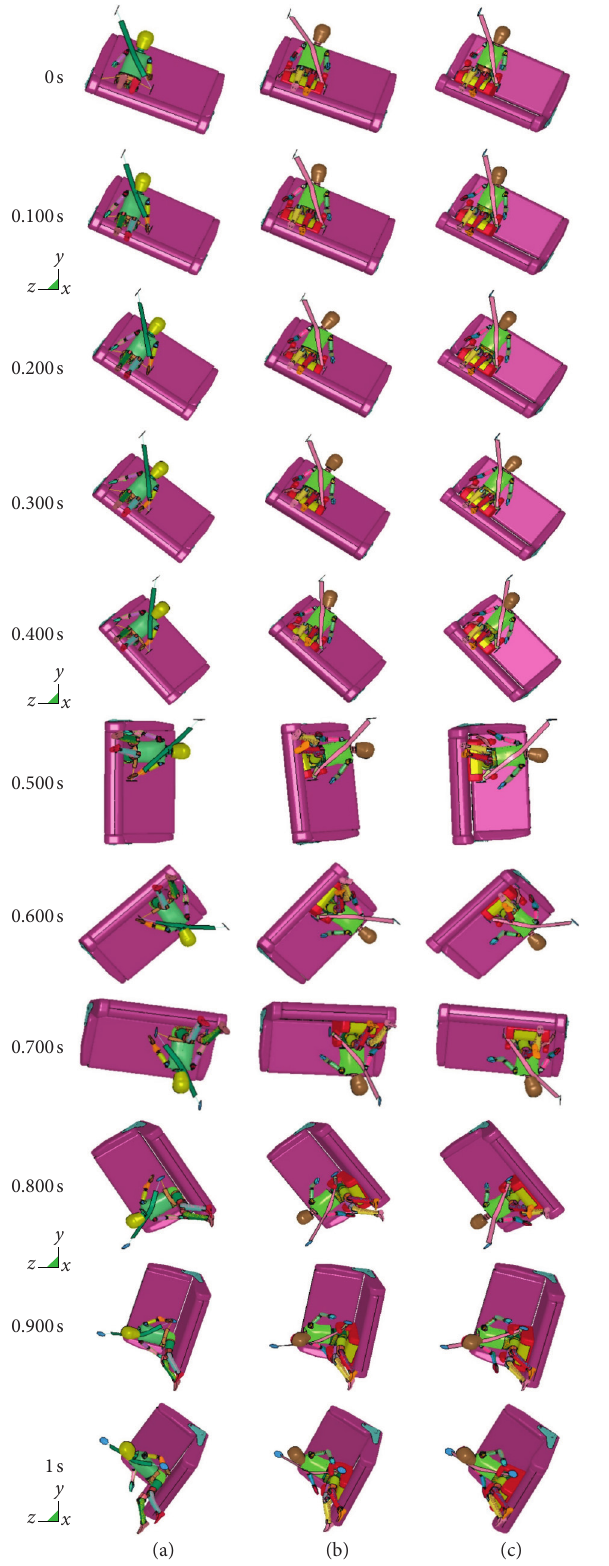
Figure 4: Dummy kinematics results: (a) VSB, (b) LBB, and (c) LBB with ISOFIX.